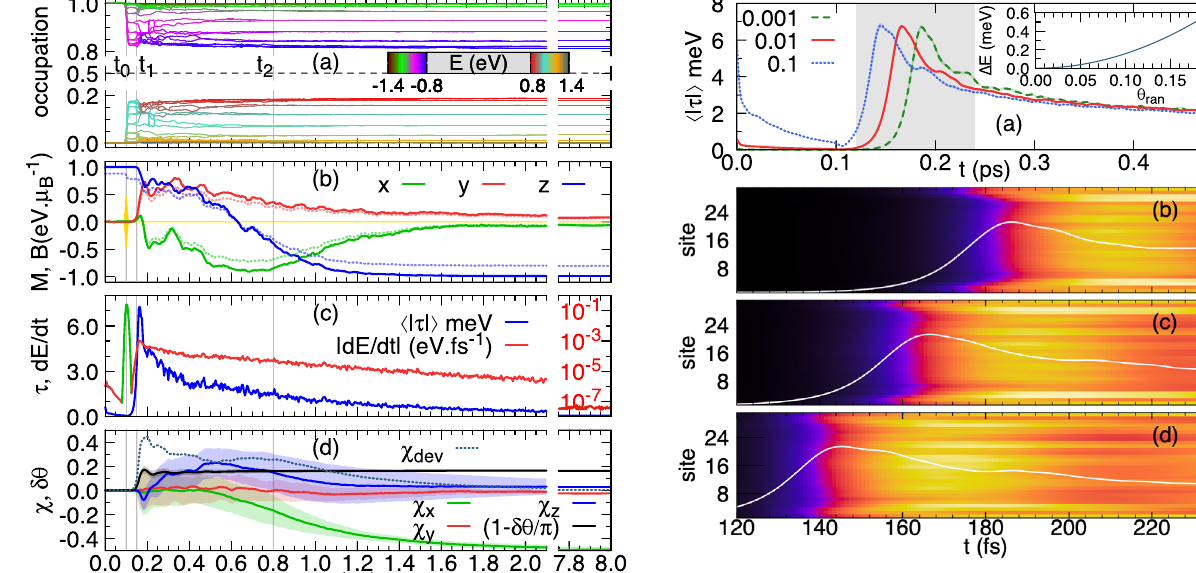
Fig. 3 Impact of randomness and edge effect on chiral formation. a Variation of effective torque as a function of initial randomness. Inset shows the average additional energy gain due to the randomness. Grey region denotes time span for which average chirality is calculated in ( b – d ). Evolution of magnitude of local chirality ∣ χ i ∣ for an initial randomness ( b ) 0.001, ( c ) 0.01, and ( d ) 0.1. The plots show the distribution averaged over 64 different initial con fi gurations. The white lines show the variation of 〈 ∣ τ ∣ 〉 shown in ( a